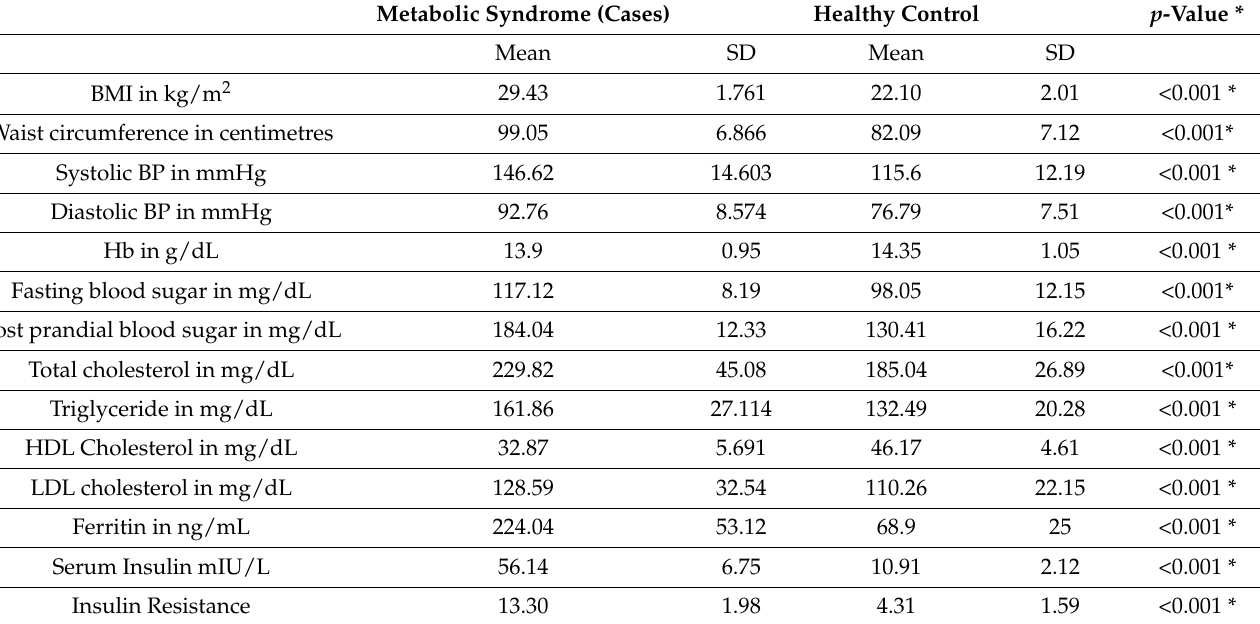
Table 1. Mean levels of body mass index (BMI), waist circumference, blood pressure, haemoglobin level (Hb), fasting and postprandial blood sugar, lipid profile, serum ferritin, serum insulin, and insulin